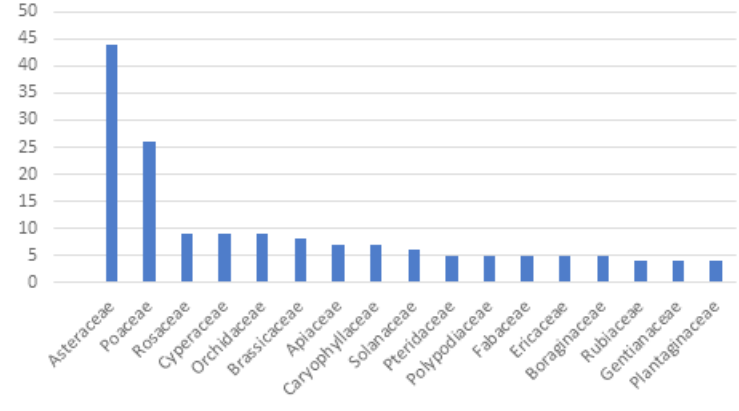
Figure 2. Number of genera per family (≥ 4 genera).